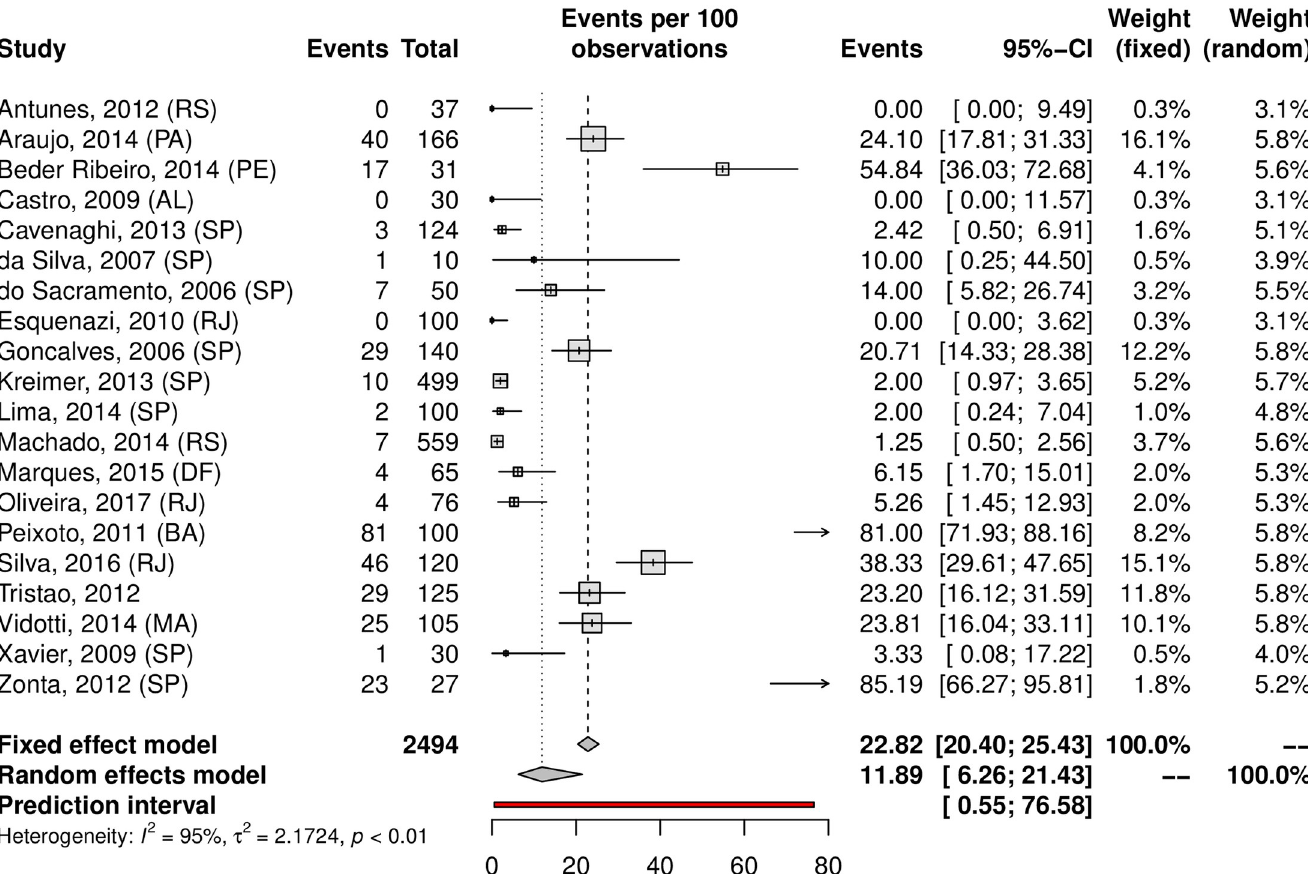
Fig 21. Overall prevalence of oral HPV infection. Forest plot of a metanalysis of studies reporting prevalence of oral infection by HPV in Brazil.